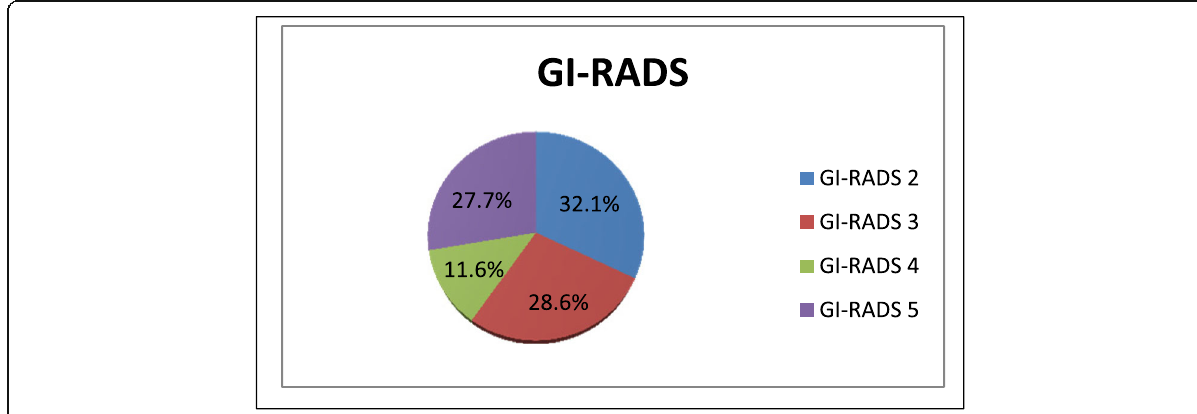
Fig. 3 Distribution of the adnexal lesions by GI-RADS